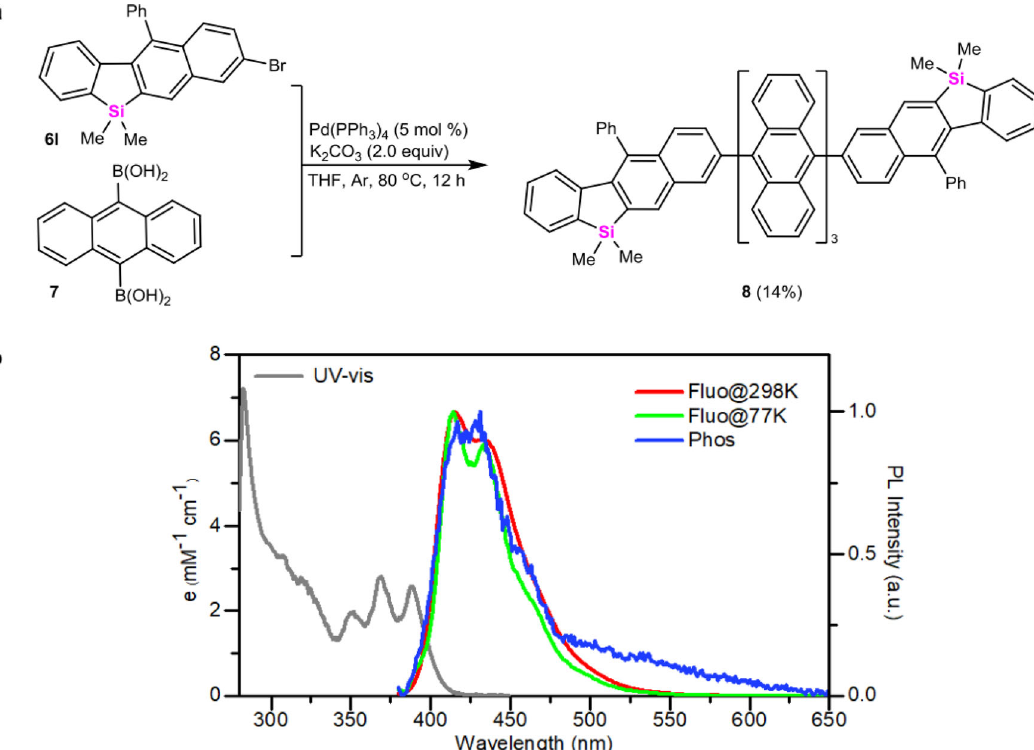
Fig. 6 Synthetic applications of this method. a Synthesis of π -conjugated teranthracene-tethered 1-phenyl-2,3-benzosila fl uorene 8 . b UV-vis absorption and PL spectra of benzosila fl uorene 8 measured in diluted toluene solution (10 − 5 M) (a.u. refers to the arbitrary unit. Fluo@298K refers to the fl uorescence spectra measured at 298K. Fluo@77K refers to the fl uorescence spectra measured at 77 K. Phos refers to the phosphorescence